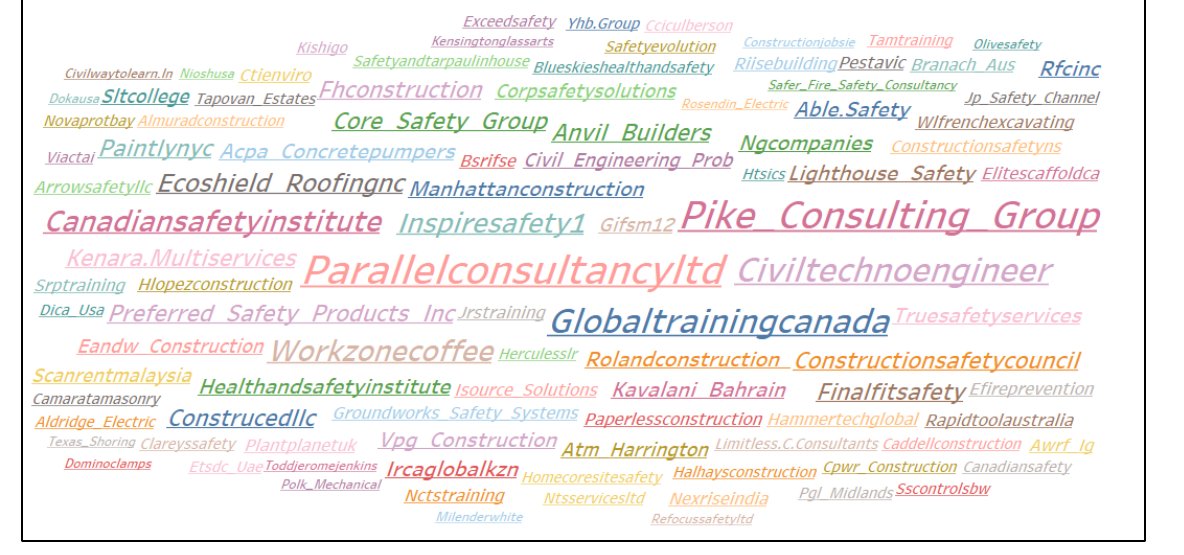
Table 4. Top 3 influential users on construction health and safety on